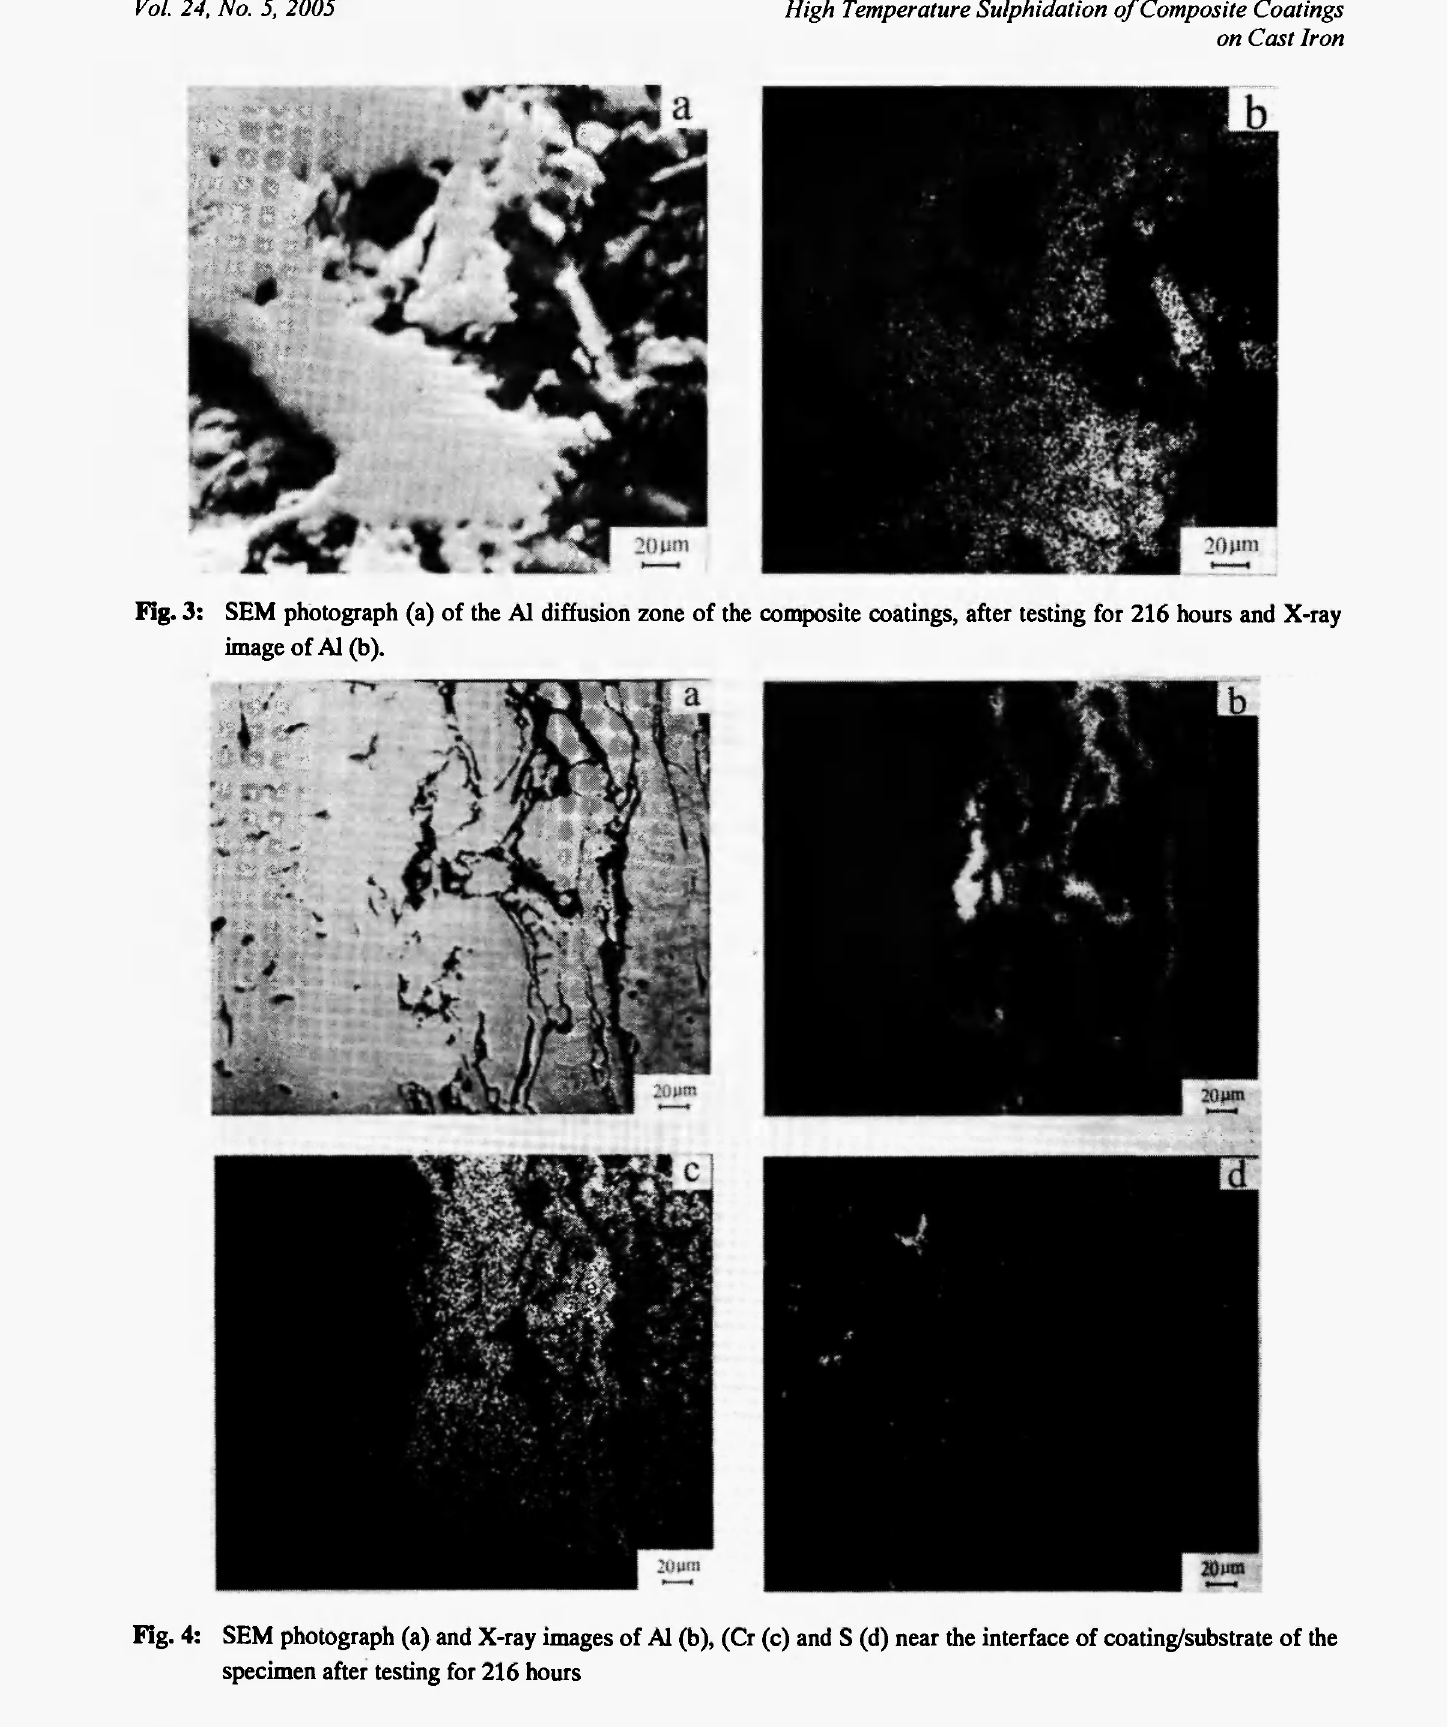
Fig. 4: SEM photograph (a) and X-ray images of Al (b), (Cr (c) and S (d) near the interface of coating/substrate of the specimen after testing for 216